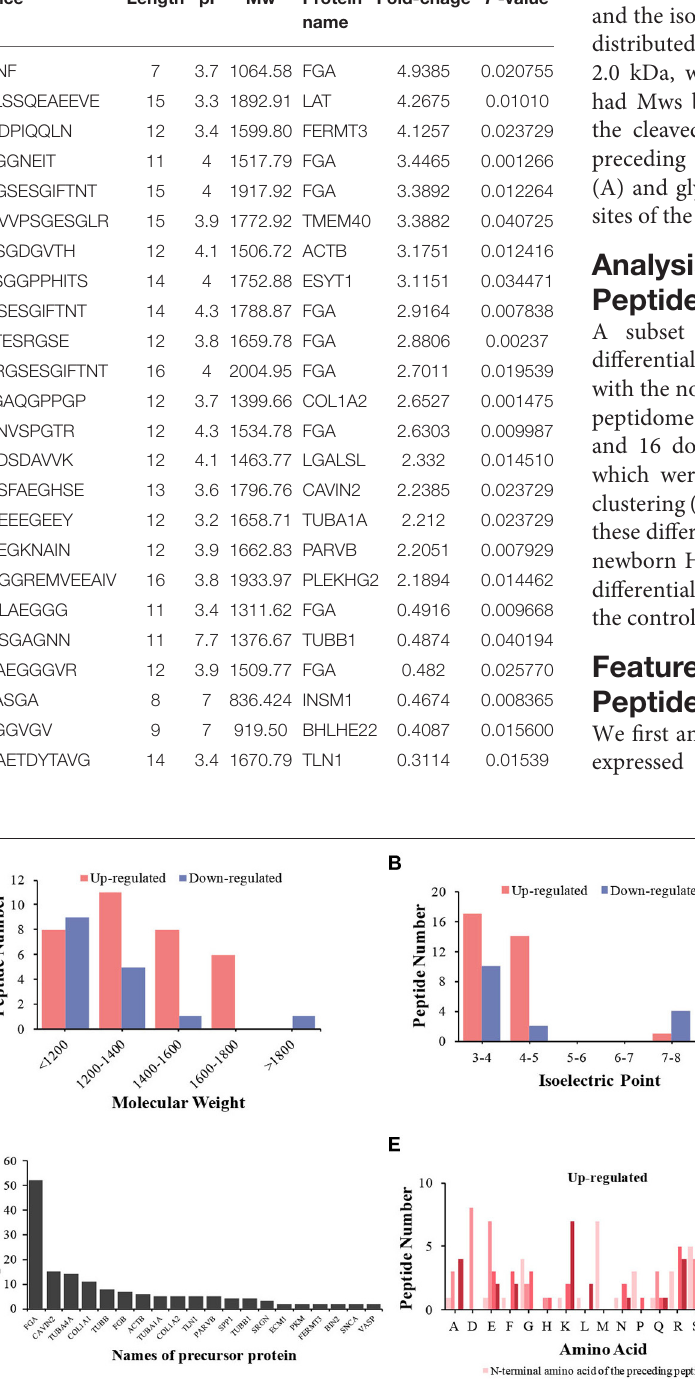
TABLE 2 | Part peptides of differentially expressed in HIE serum compared with control (Foldchange > 2 or < 0.5). Sequence Length pI